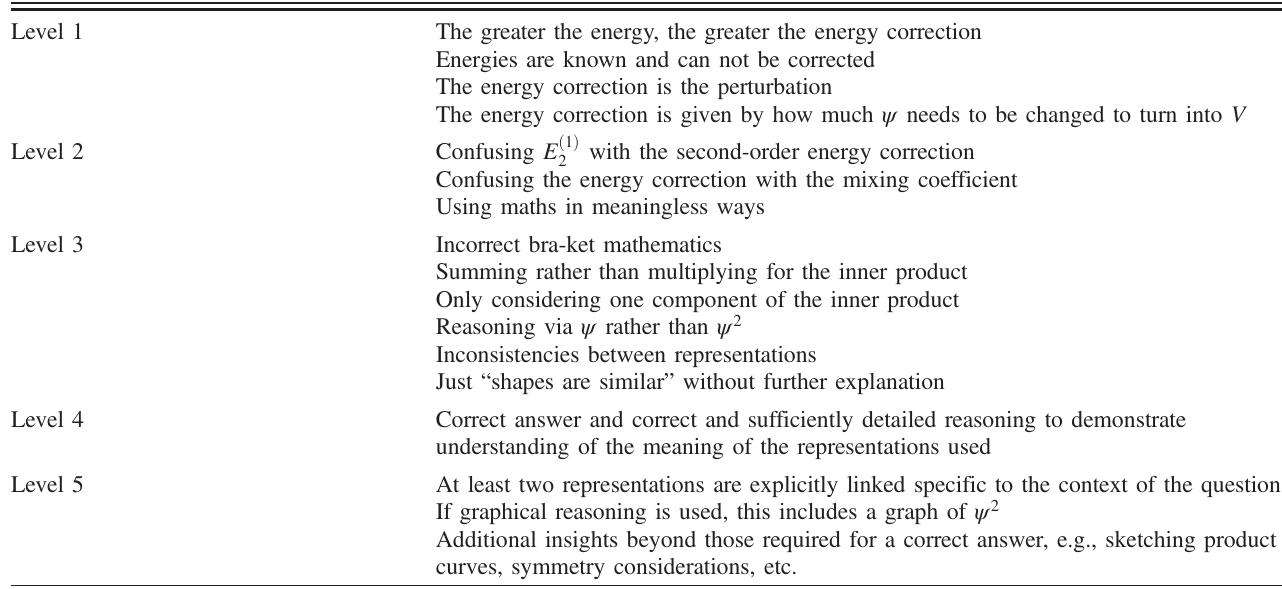
TABLE I. Descriptors for the different representational competence levels for the pre-, mid-, and post-test responses. Level